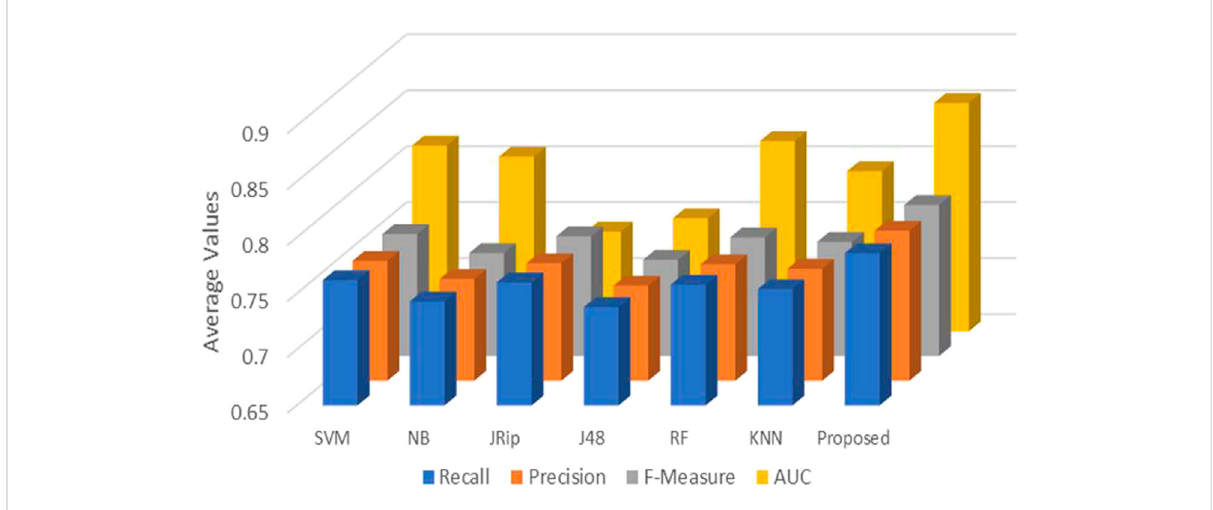
FIGURE 12 Average Recall, Precision, F-Measure, and AUC values.